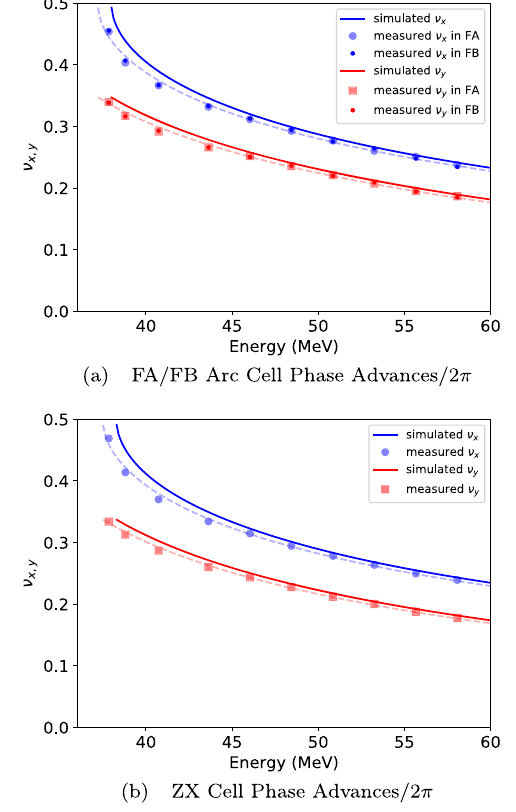
FIG. 4. Phase advance per cell per 2 π in the FA and FB arc sections (a) and in the ZX straight section (b). Measured data are shown with circular markers. Square markers indicate the measured data with the energy scaled by a factor of 1.02.